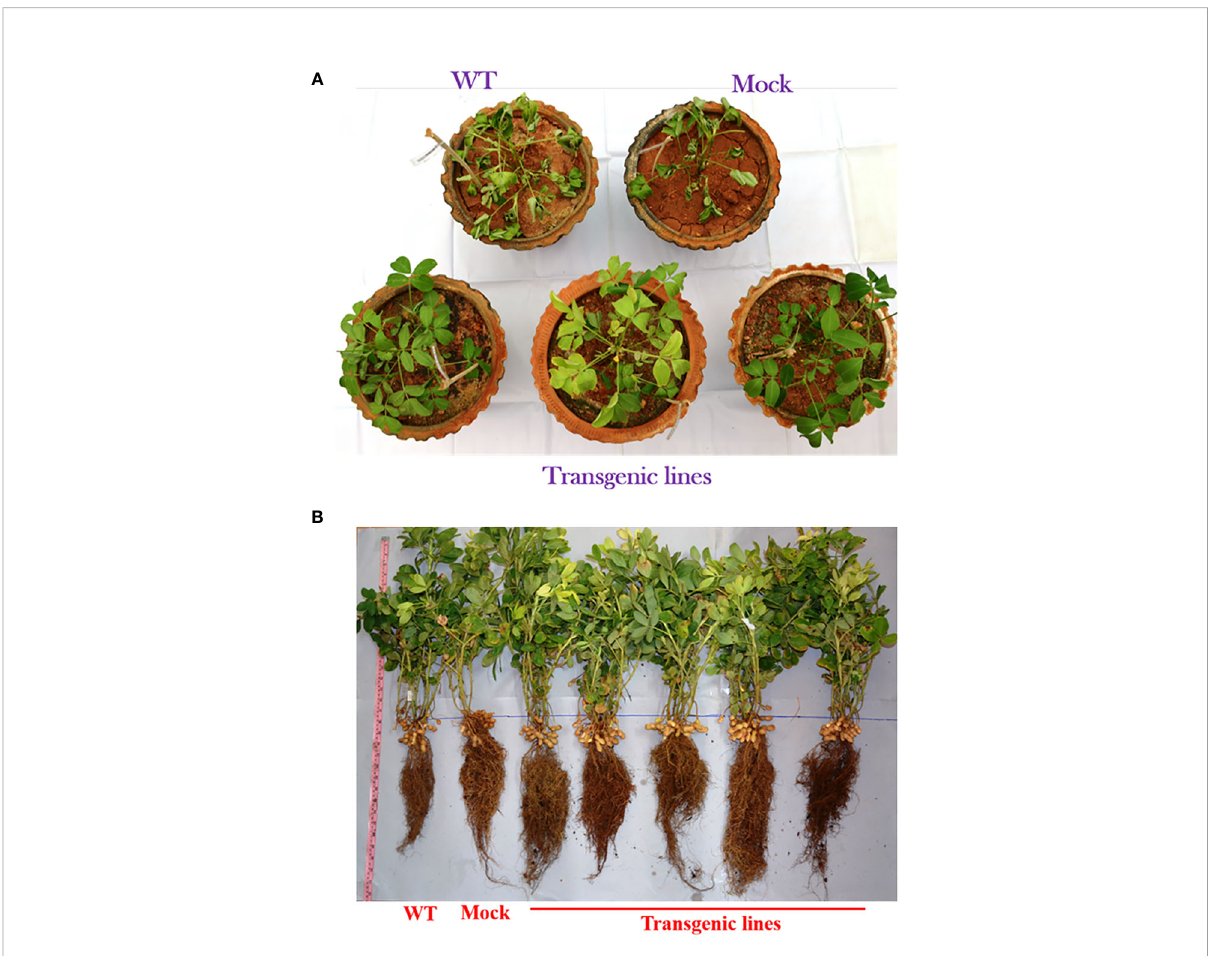
FIGURE 4 Response of groundnut transgenicplants todrought stress. (A) . Drought stress assay - Imageshowing the stay-green natureof multigene transgenic groundnut plants after10days of drought stress. Wild type (WT) and mock plants showed severevisiblewiltingsymptoms whereas transgenicplants showed stay green natureunderdrought stress. (B) Phenotypic - trait analysis ofmultigene transgenic groundnut plants at harvest stage. Image showing profuse growthof lateral rootdensity,shootbiomass and morepods in multigene transgenic plants compared to wild type and mock plants.